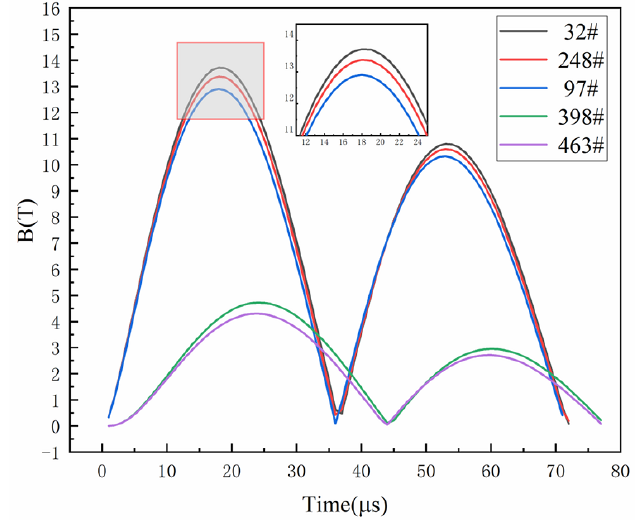
Figure 12. Magnetic induction intensity of typical nodes in the thickness direction of the